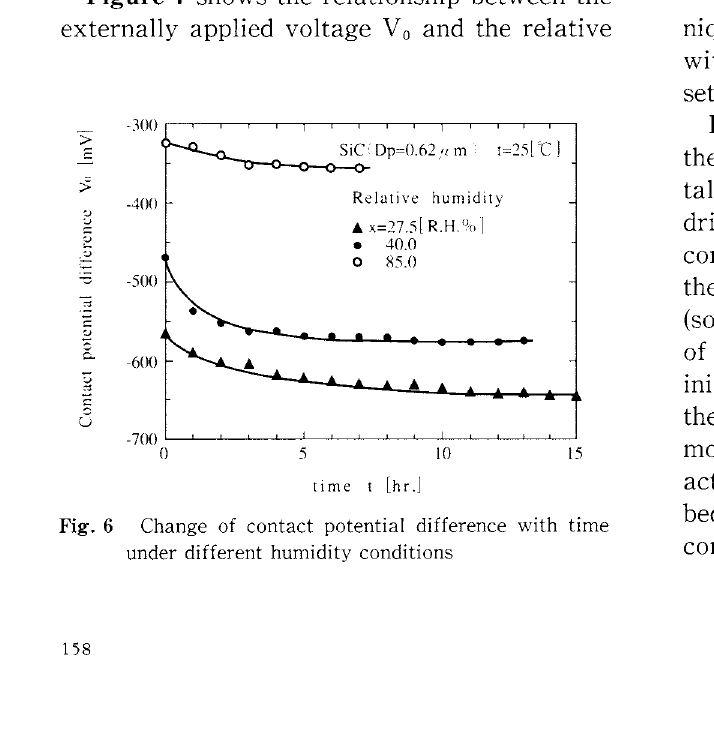
points per minute and indicate the maximum and minimum values.